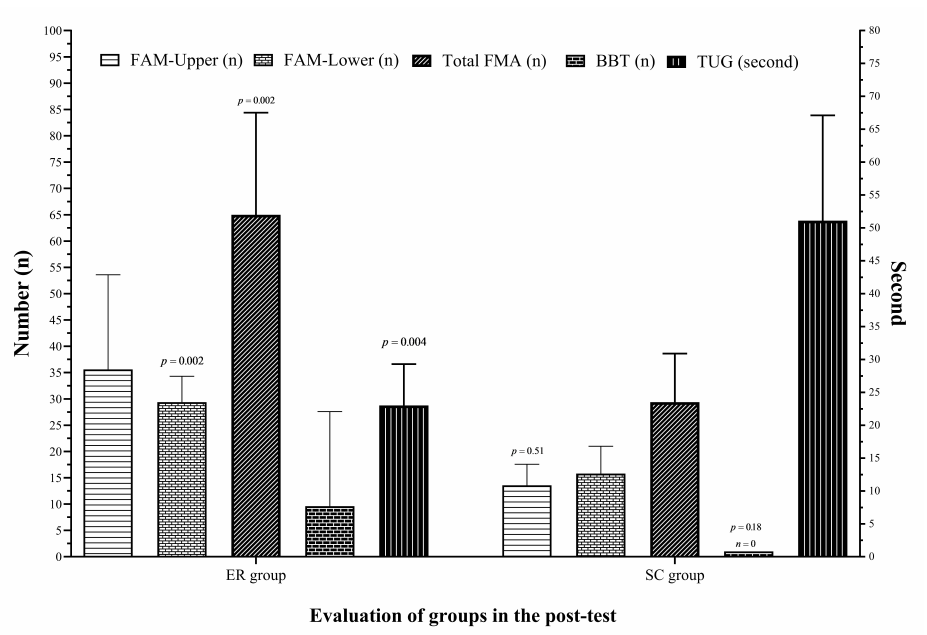
Figure 2. Comparison of groups in assessments. ER = Exercise rehabilitation, SC = Standard care, FMA = Fugle-Meyer Assessment, BBT = Box and Blocks Test, TUG = Time Up and Go. The analysis of the data related to the BBT showed no significant differences between the experimental (9.6 ± 18.3) and control (0) groups ( p = 0.3), but the TUG test showed significant differences between the experimental (23 ± 6.3) and control (51.1 ± 16) groups ( p = 0.004). The information on individual test evaluations before and after the neuromuscular rehabilitation protocol can be seen in Table 3. Table 3. Results of effectiveness measures for each